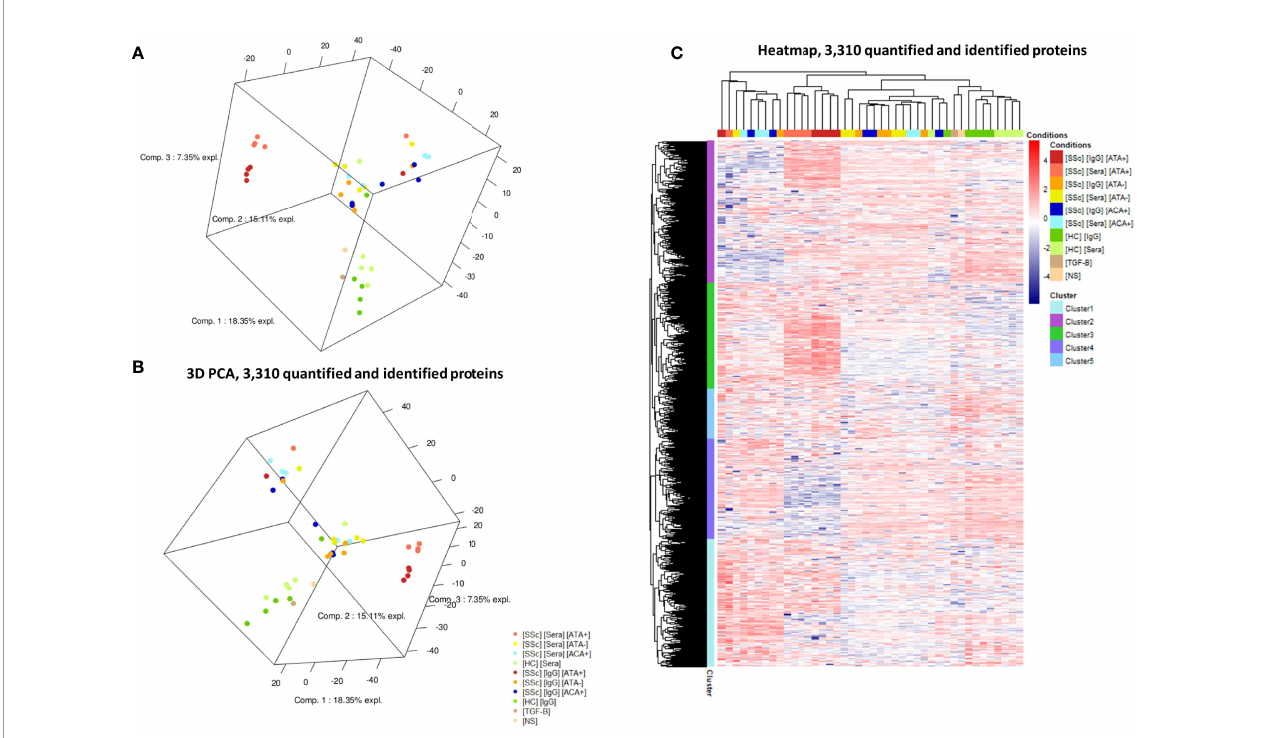
FIGURE 2 | Protein expression pro fi les in LC-MS/MS analysis. (A, B) : two different views of 3D-PCA scatter plots for the analyzed cell samples. PCA highlighted FB protein expression according to the patient serotype of the puri fi ed IgG. (C) Heatmap representing the 3,310 differentially expressed proteins in all samples. Cluster analysis identi fi ed 5 different clusters of protein expression. [HC] [Sera], sera from healthy controls; [HC] [IgG], IgG from healthy controls; [SSc] [Sera] [ATA+], sera from dcSSc anti-topoisomerase-I positive patients; [SSc] [IgG] [ATA+], IgG from dcSSc anti-topoisomerase-I positive patients; [SSc] [Sera] [ATA − ], sera from dcSSc anti-topoisomerase-I negative patients; [SSc] [IgG] [ATA − ], IgG from dcSSc anti-topoisomerase-I negative patients; [SSc] [Sera] [ACA+], from sera lcSSc anti- centromere positive patients; [SSc] [IgG] [ACA+], IgG from lcSSc anti-centromere patients; [TGF-B], FB stimulated in the presence of TGF- b ; [NS], non stimulated FB. PCA, principal component